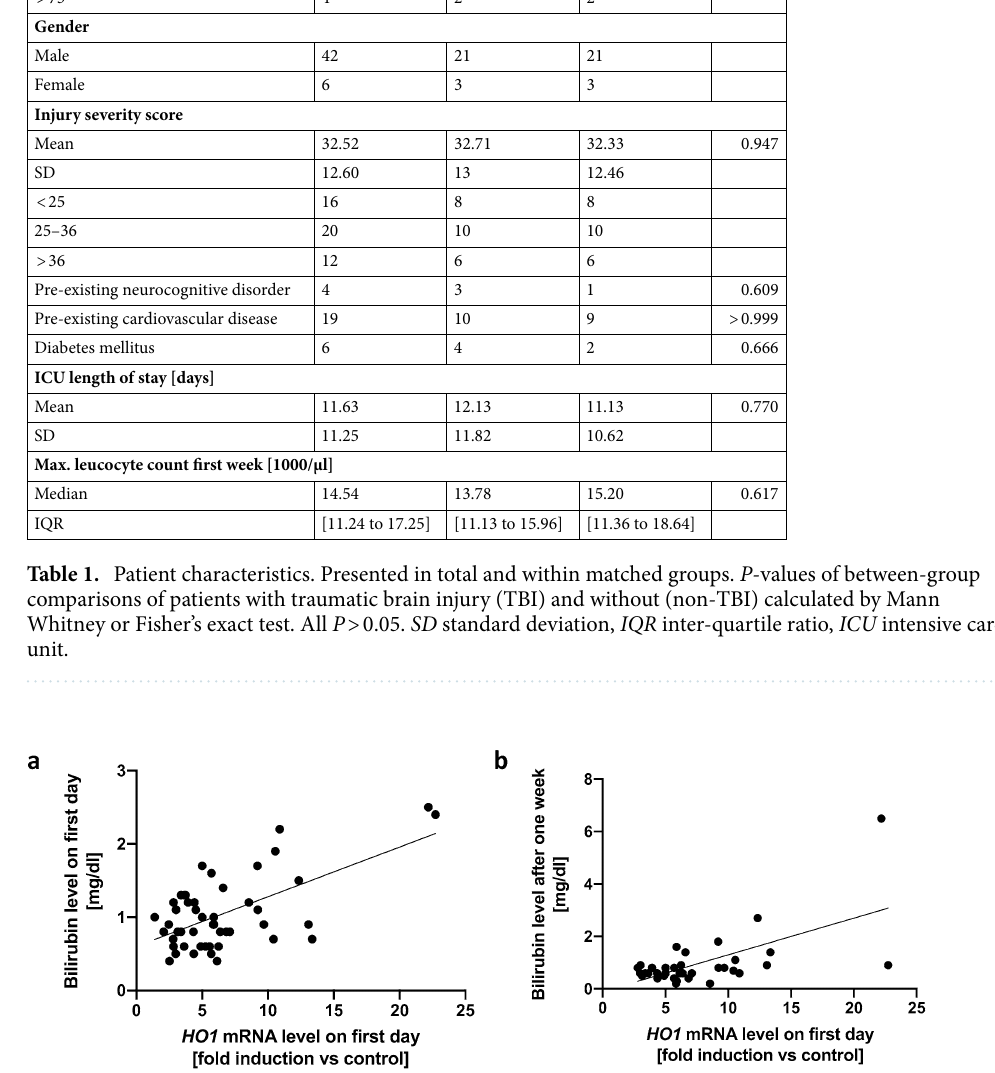
Figure 2. Correlation of systemic HO1 expression with bilirubin plasma concentration. Linear regression curves of systemic HO1 expression on admission and (a) bilirubin concentration on admission (Spearman: r = 0.315, P = 0.029, Linear Regression: r 2 = 0.376, P < 0.0001) and ( b) bilirubin expression after 1 week (Spearman: r = 0.424, P = 0.011, Linear Regression: r 2 = 0.377, P < 0.0001). HO1 heme oxygenase